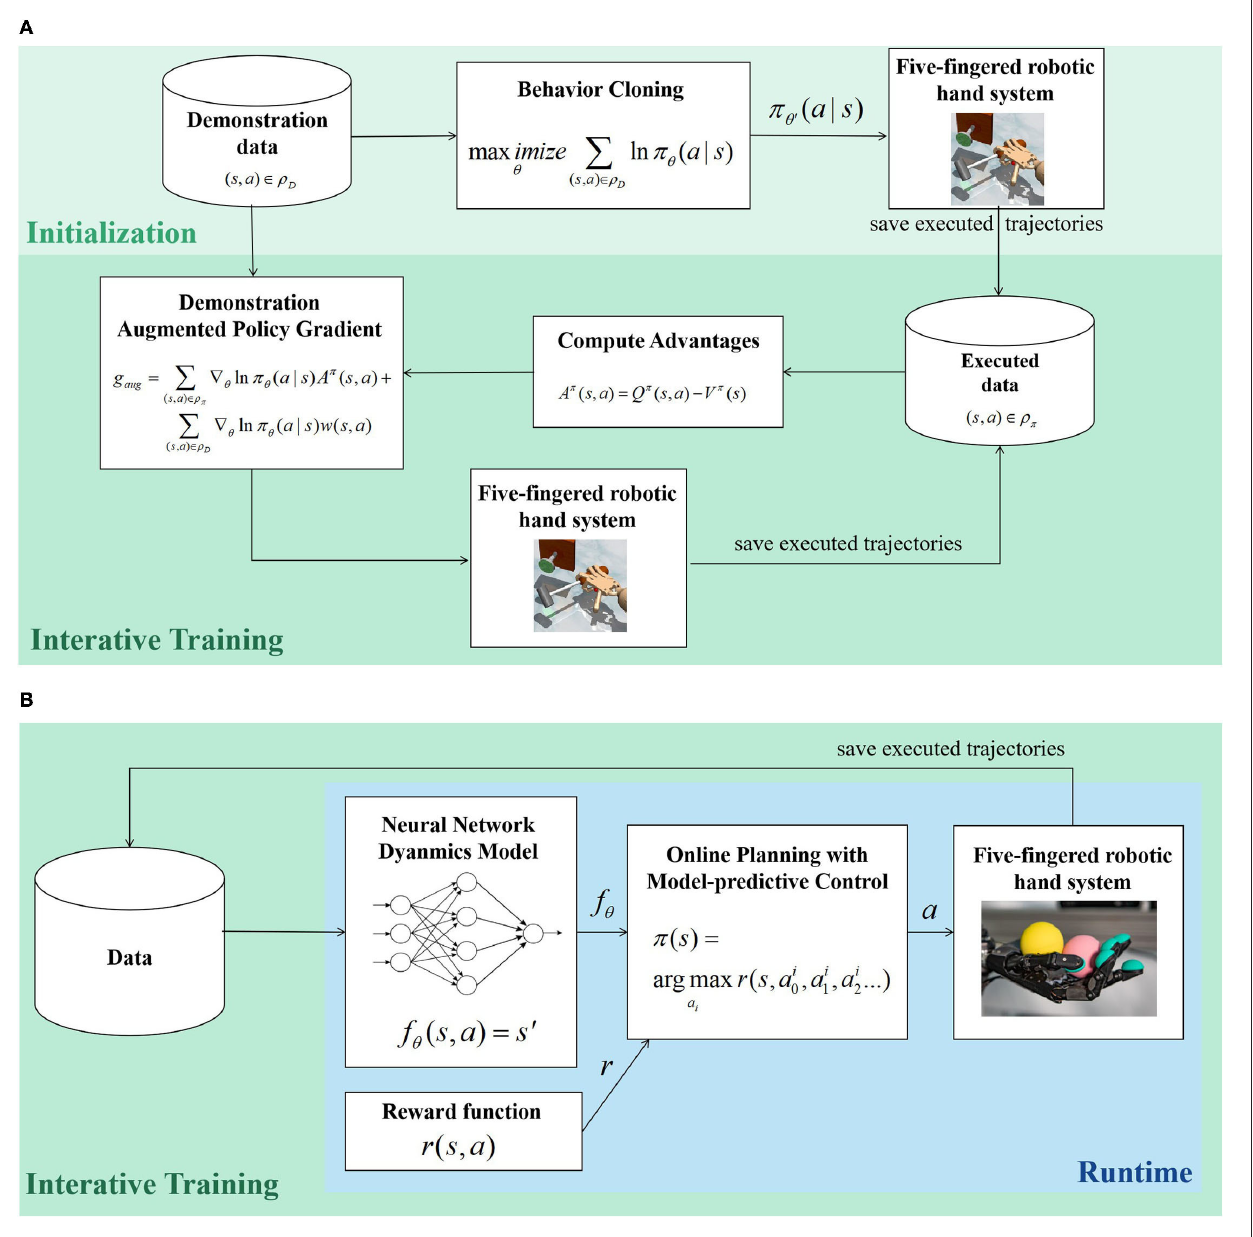
FIGURE 5 | The brief diagrams of two learning-based five-fingered robotic hand manipulation methods. (A) A model-free, learning from demonstration method: Demo Augmented Policy Gradient (DAPG) (Rajeswaran et al., 2017), (B) A model based reinforcement learning method: Online planning with deep dynamics (PDDM) (Nagabandi et al.,